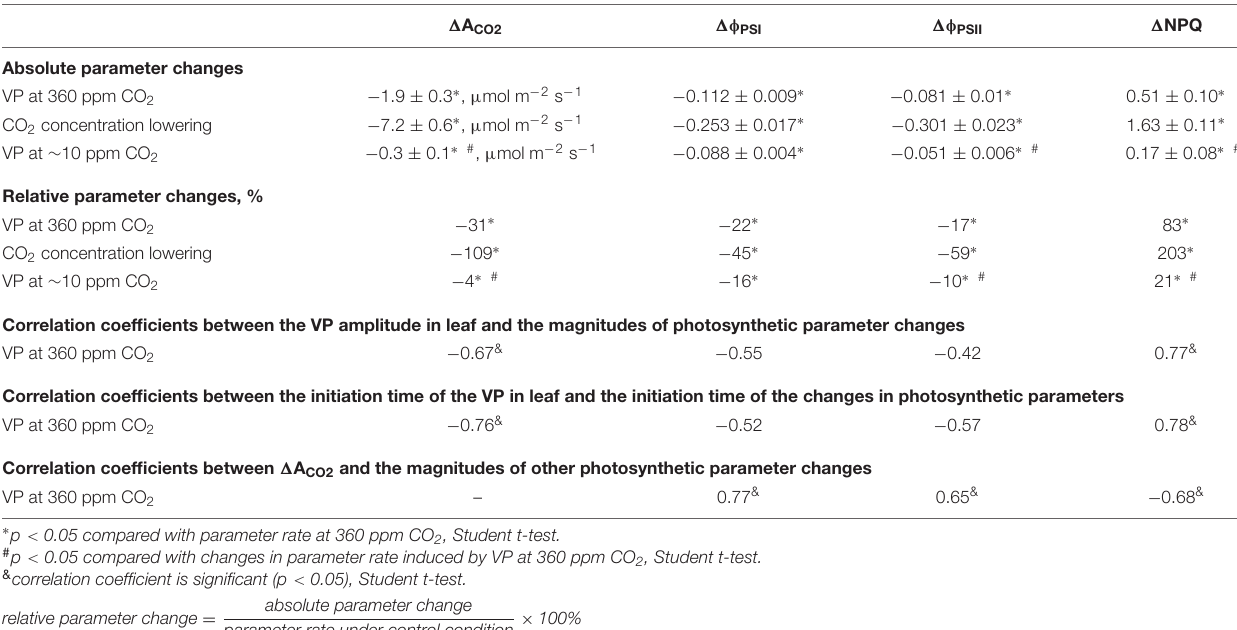
TABLE 1 | Characteristics of changes in photosynthetic parameters after VP induction and CO 2 concentration